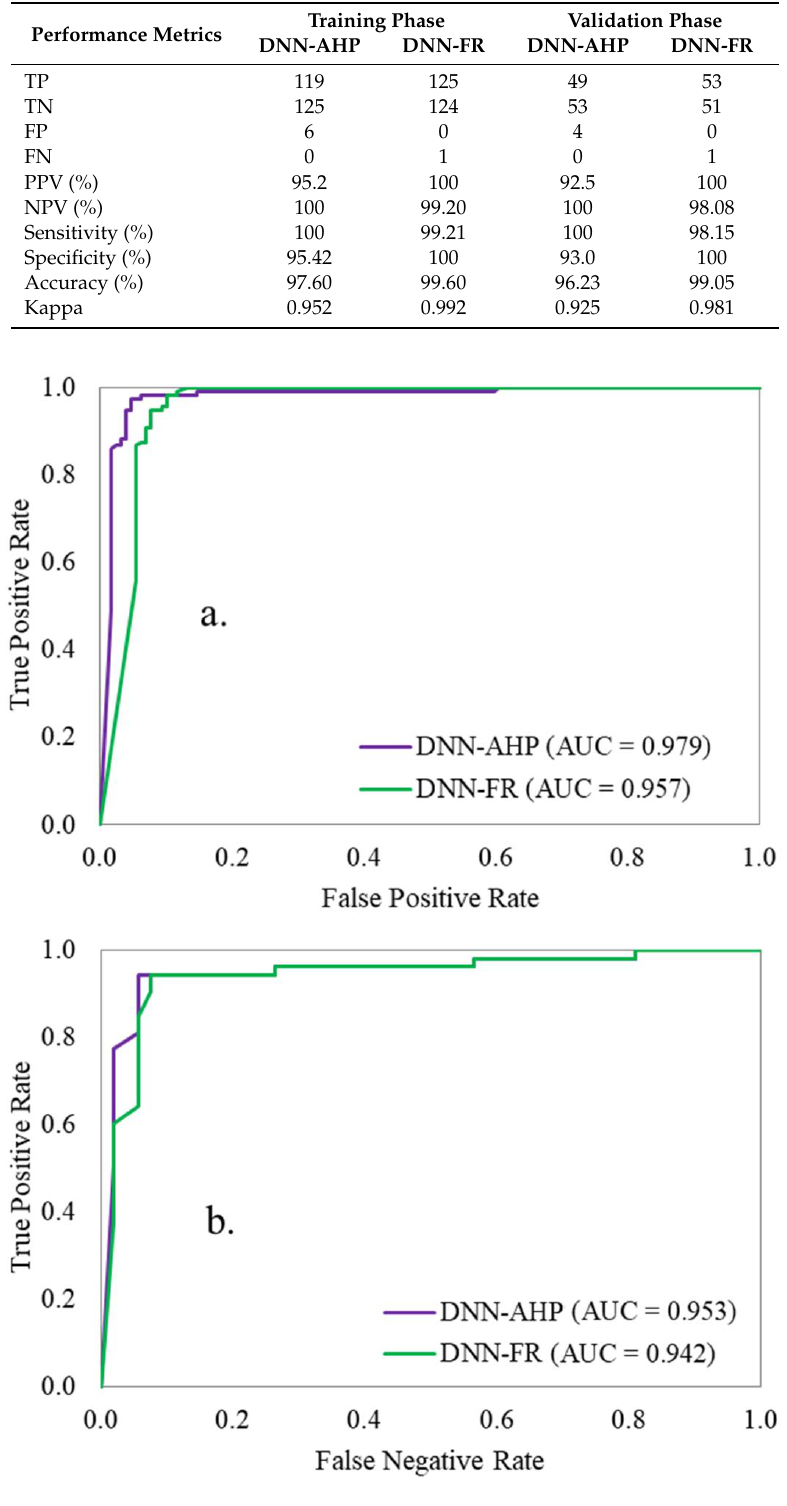
Figure 9. ROC Curve (( a ) Succes Rate; ( b ) Prediction Rate).